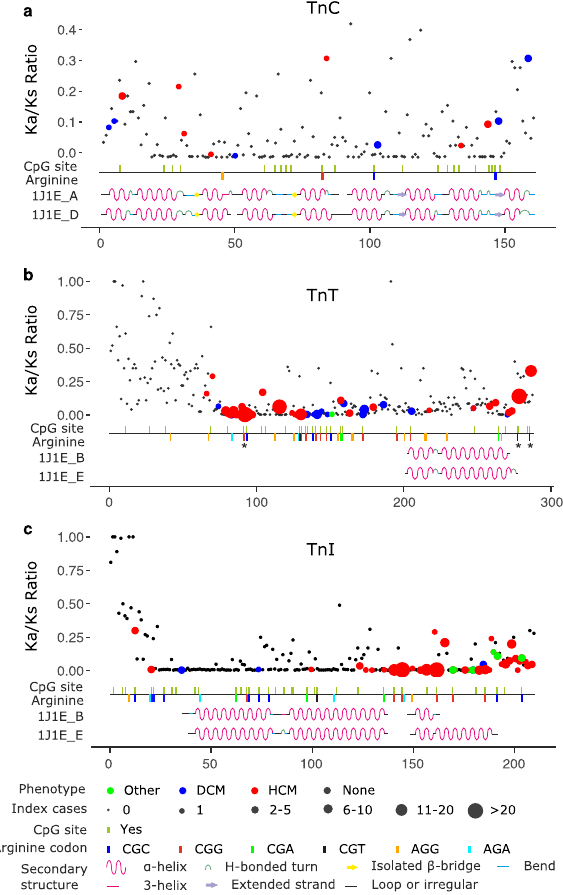
Fig. 2 Summary of codon-speci fi c selective pressure in human troponins. a Troponin C; b Troponin T; and c Troponin I. The amino acids sequences run on the x -axis and the selective pressure (represented by K a /K s ratio) is on the y -axis. Each dot represents an amino acid in the protein sequences, the colour indicates disease phenotype and the size indicates the number of cases carrying variations at those sites. The CpG sites in the DNA sequence are marked by vertical bars. Codons for arginine are colour-coded. Secondary structure annotations are shown at the bottom. Asterisk indicates hotspot variation